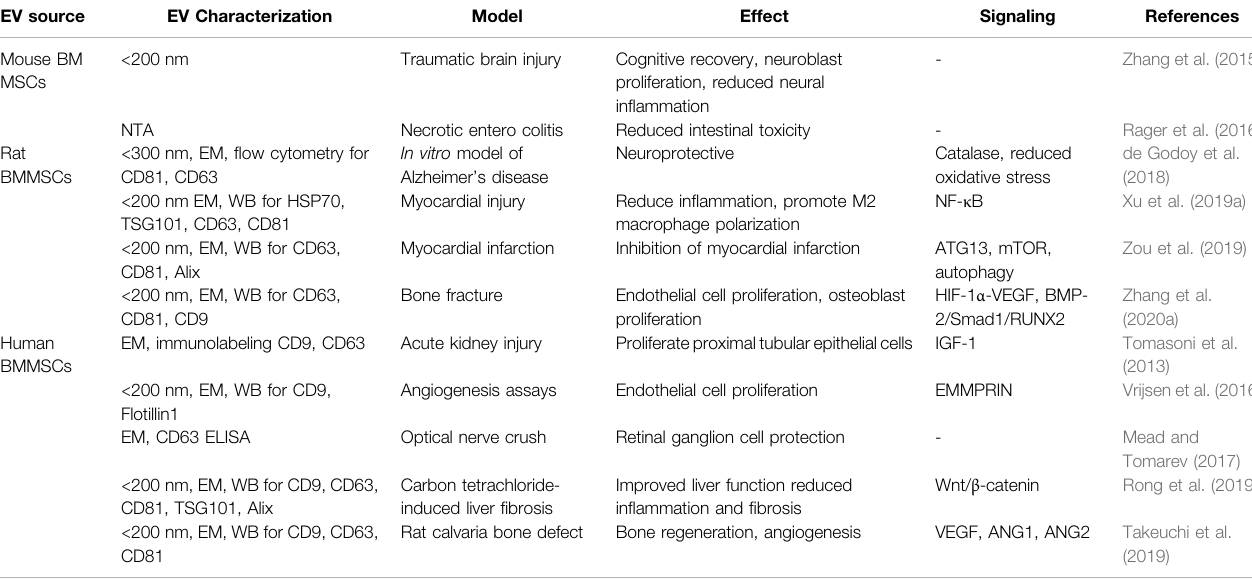
TABLE 1 | The biological effect of BMMSC-EVs on organ and cell repair in various non-radiation injury